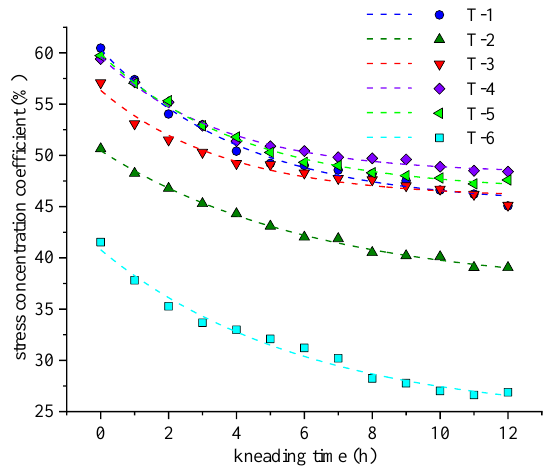
Figure 14. Fitting curve of stress concentration coefficient.